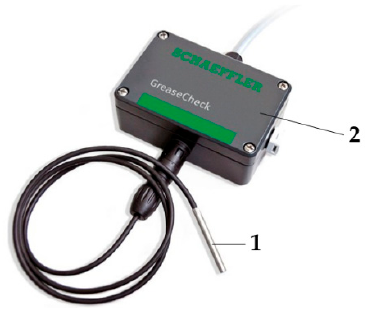
26 of 37 Figure 27. Sensor figures (ENIG and zinc coating indicated by gold and white traces) (Reprinted with permission from Ref. [204]. Copyright 2020 Taylor & Francis Group, LLC). Currently, a grease condition monitoring tool has been developed by Schaeffler Co. [205] (as indicated in Figure 28). The grease condition monitoring tool consists of a tiny grease sensor and an electronic evaluation system. A miniature sensor (5 mm diameter) is